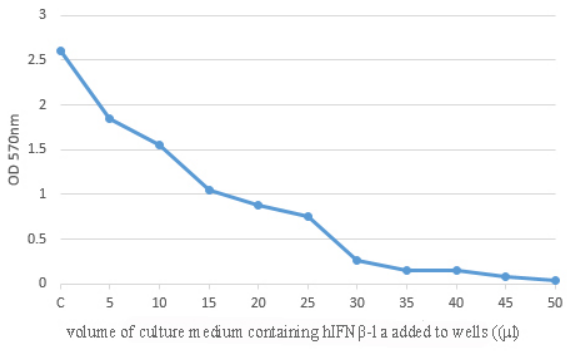
Figure 9. Linear diagram of OD at 570 nm by viable human dermal fibroblasts treated with different volumes (0 to 50 μL) of culture medium containing hIFN β -1a protein produced by CHO